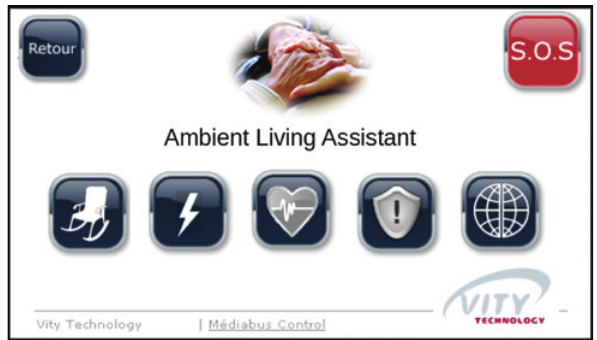
Figure 11: Final HCI Example Generated for the User